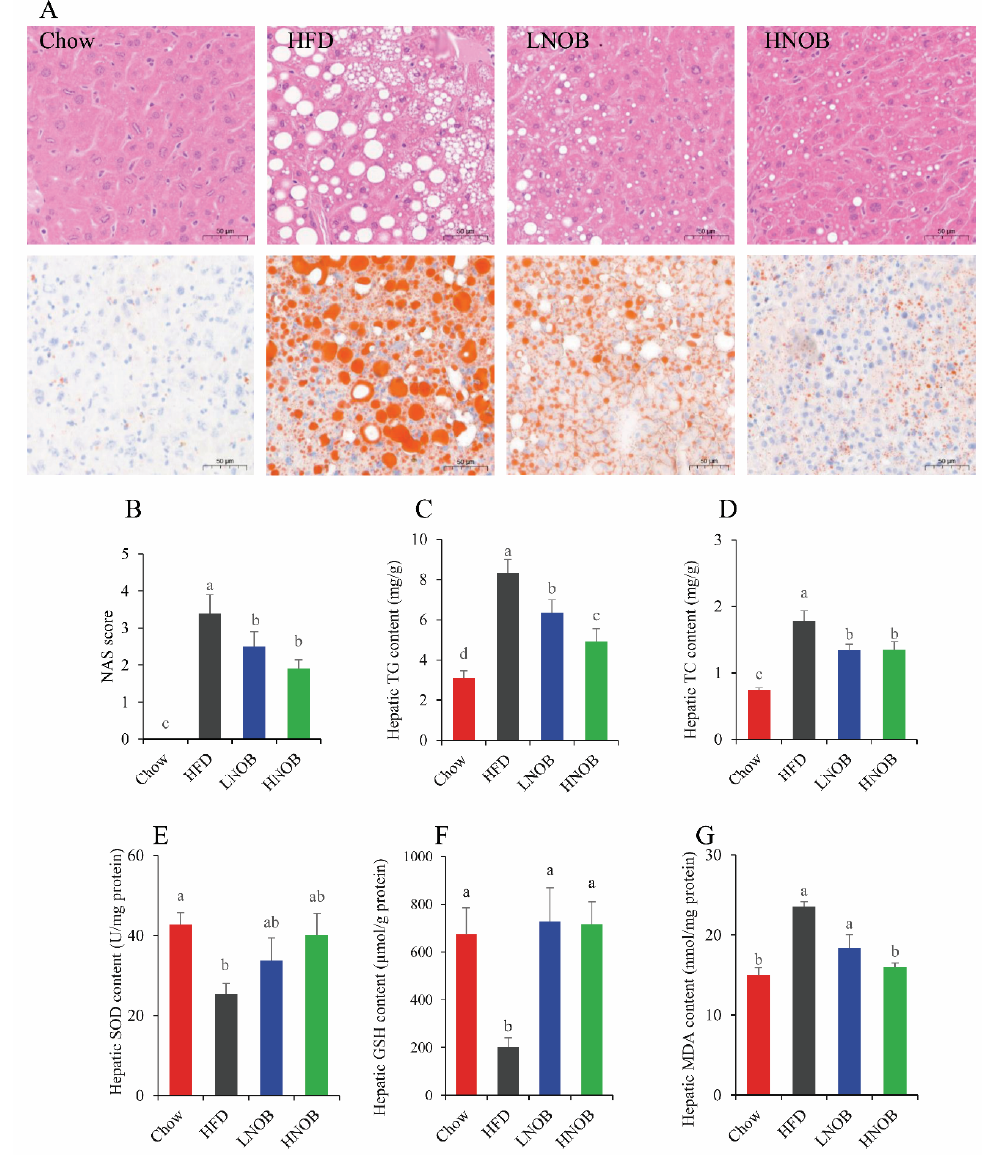
Figure 2. NOB ameliorated hepatic steatosis and oxidative stress in HFD-induced mice. ( A ) HE and Oil Red O staining (×200). ( B ) NAS score. ( C ) TC content in the liver. ( D ) TG content in the liver. ( E ) Hepatic SOD content. ( F ) Hepatic GSH content. ( G ) Hepatic GSH content. Data are shown as mean ± SD ( n = 8). Data with different letters (a, b, c) represent significant difference ( p < 0.05), whereas bars with the same letter correspond to values that exhibit no significant differences. In the case where two letters are present on top of the bars in E, each letter should be compared separately with the letters of other bars to determine whether the values show significant differences.